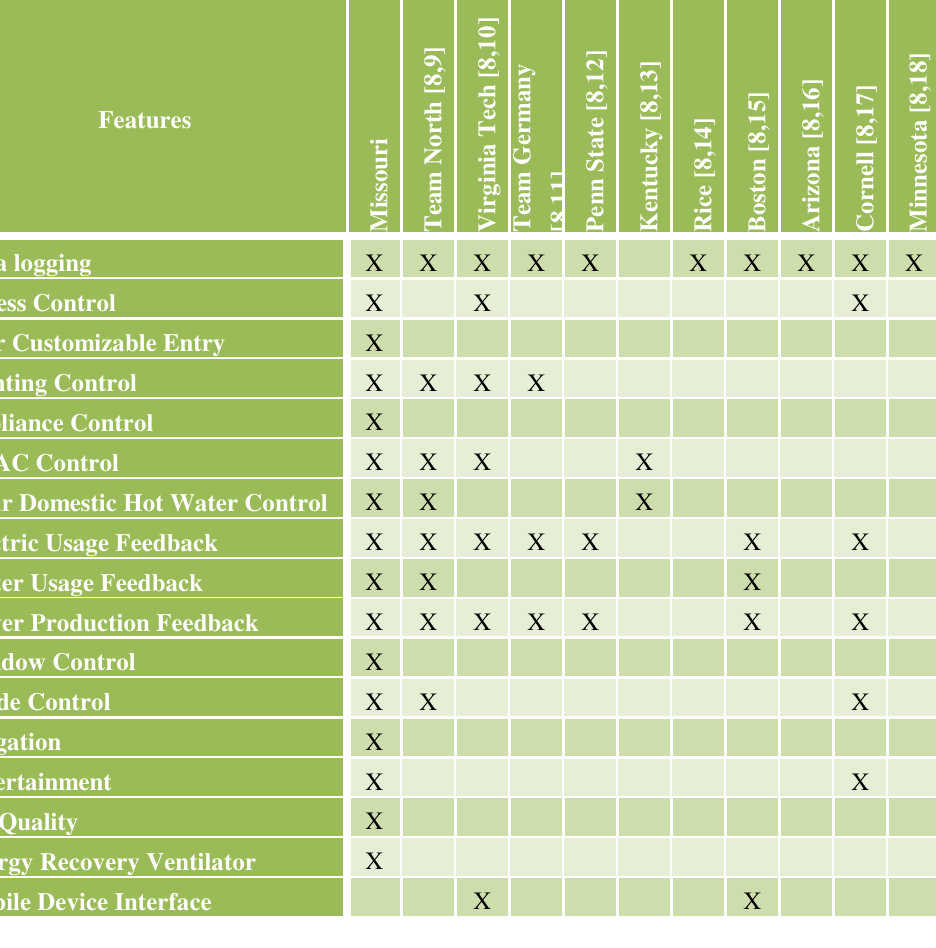
Table 1. U.S. Department of Energy 2009 Solar Decathlon home automation